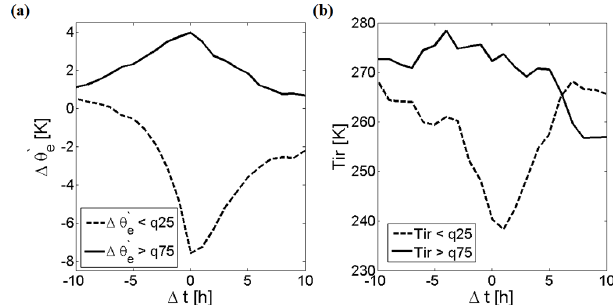
Figure 13. Ensemble analysis for (a) (cid:49)θ (cid:48) e and (b) Tir considering 10h before and 10h after the event’s onset. The cases where (cid:49)θ (cid:48) e at the event’s onset is less than the 25th percentile (dashed lines) and more than the 75th percentile (full lines) are shown. In total, 72 cases were considered in the analysis (36 cases for each